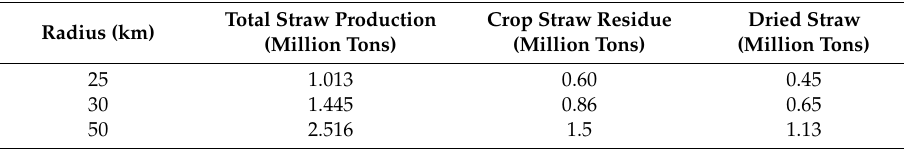
Table 1. Total straw production and straw available for biomass power